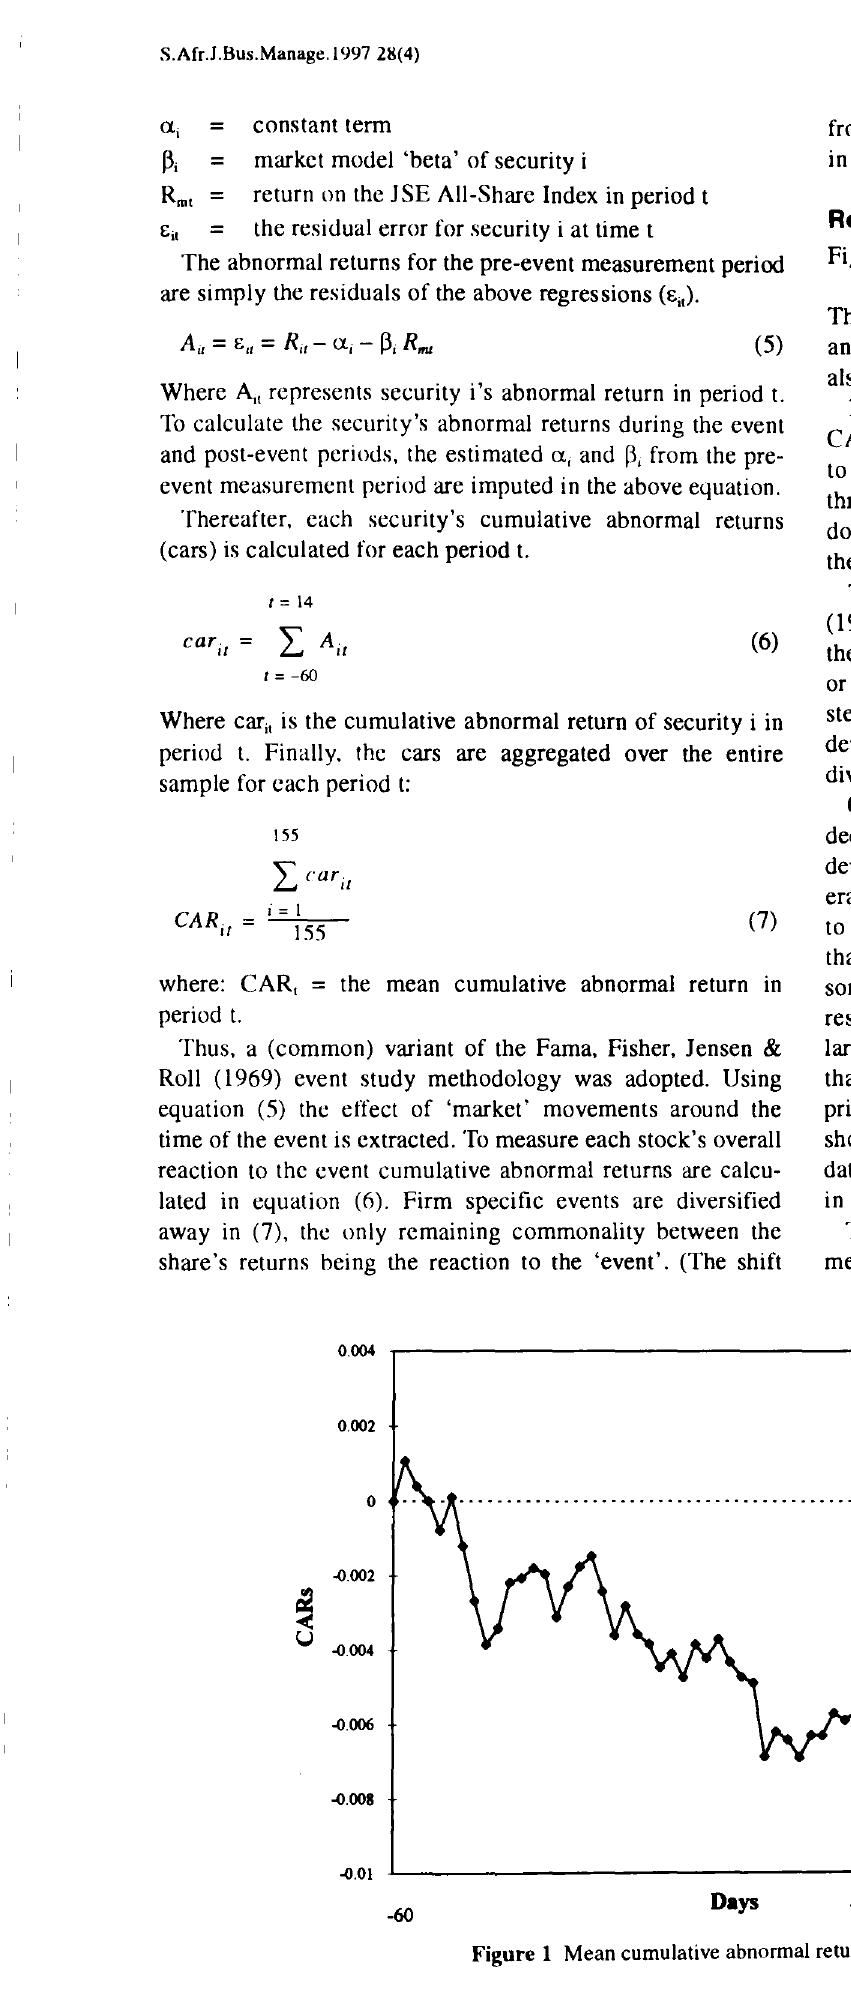
Figure 1 Mean cumulative abnormal returns around the ex-dividend